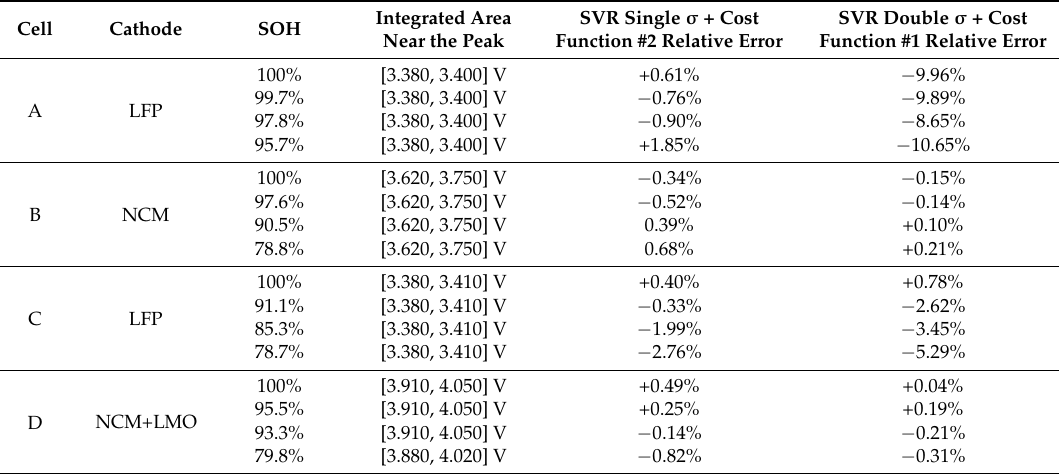
Table 4. The accuracy of the recommended SVR algorithms in capturing the features of the characteristic peaks (height integration near the peak) in the IC